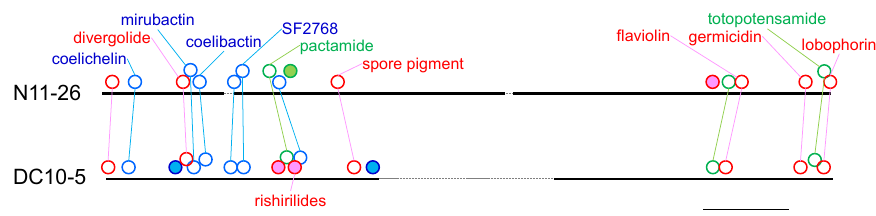
Figure 4. Positions of PKS and NRPS gene clusters in the putative chromosomal DNAs of S. olivaceus N11-26 and DC10-5. Contig sequences encoding these gene clusters are shown in bold black lines. Red circle, PKS gene cluster; blue circle, NRPS gene cluster; green circle, hybrid PKS/NRPS gene cluster. The same gene clusters are connected by lightly colored lines. Gene clusters specific to one of the strains are filled by pink (PKS gene cluster), light blue (NRPS gene cluster) or light green (hybrid PKS/NRPS gene cluster). Although known compounds that were predicted by our bioinformatic analysis are indicated here, putative products of orphan clusters are not shown since their compound names are unclear, as shown in Table 3. The ‘rishirilides’ in DC10-5 includes rishirilides B and C, lupinacidin A and galvaquinone B [25]. The ‘flaviolin’ includes flaviolin and 1,3,6,8-tetra- hydroxynaphthalene.